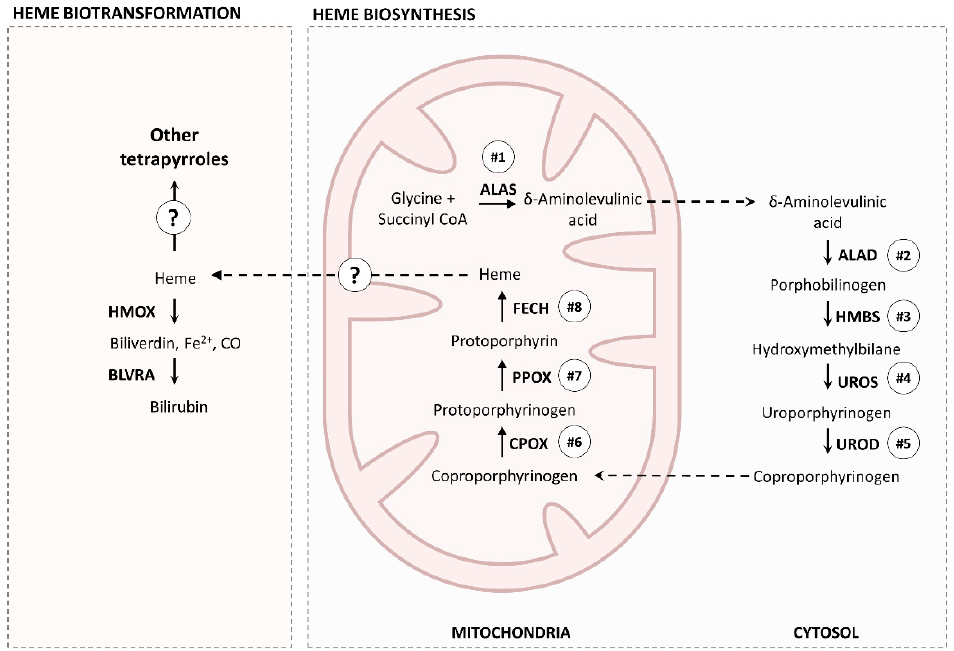
Figure 9. A simplified representation of the essential heme metabolic pathways shared between Eulalia and higher-order Eumetazoa, especially vertebrates. ALAS, aminolevulinic acid synthase; ALAD, δ -aminolevulinic acid dehydratase; HMBS, hydroxymethylbilane synthase; UROS, uroporphyrinogen synthase; UROD, uroporphyrinogen decarboxylase; FECH, ferrochelatase; PPOX, protoporphyrinogen oxidase; CPOX, coproporphyrinogen oxidase; HMOX, heme oxygenase; BLVRA, biliverdin reductase.